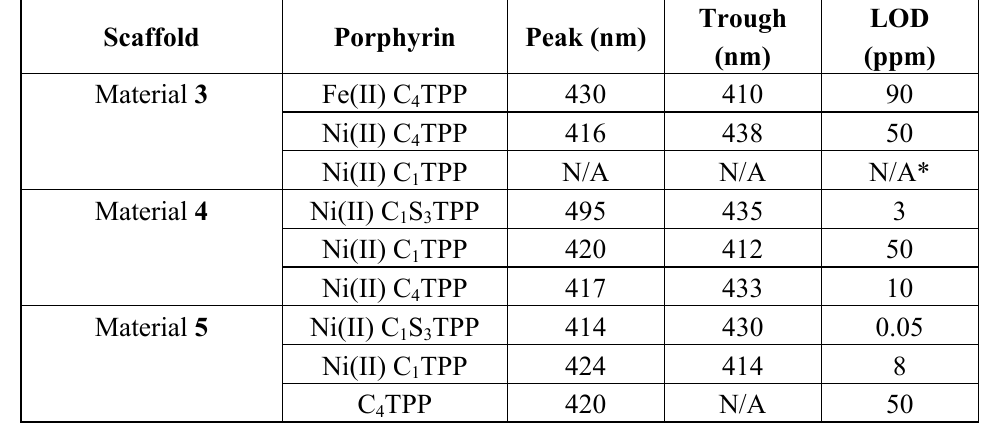
Table 3. Interaction of porphyrin embedded materials with paraoxon. Peak and trough positions are taken from difference excitation spectra. Limits of detection are based on the concentration required to yield a ∆ I of three times the noise in the measurement. Scaffold Porphyrin Peak